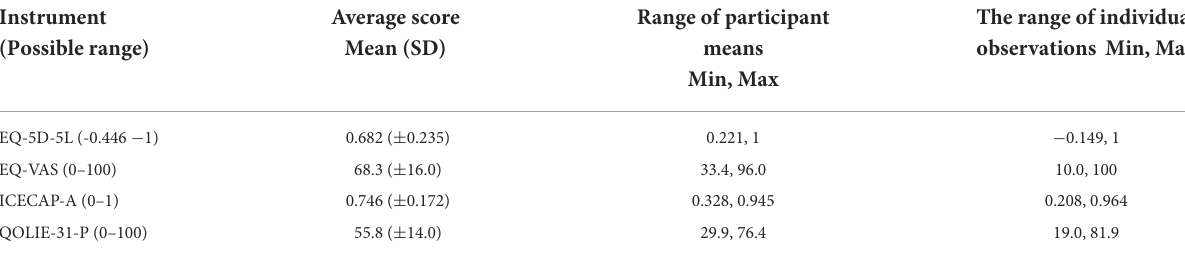
TABLE 2 Summary statistics for EQ-5D-5L, EQ-VAS, ICECAP-A, and QOLIE-31-P over five assessments within a 1-year follow-up ( n =